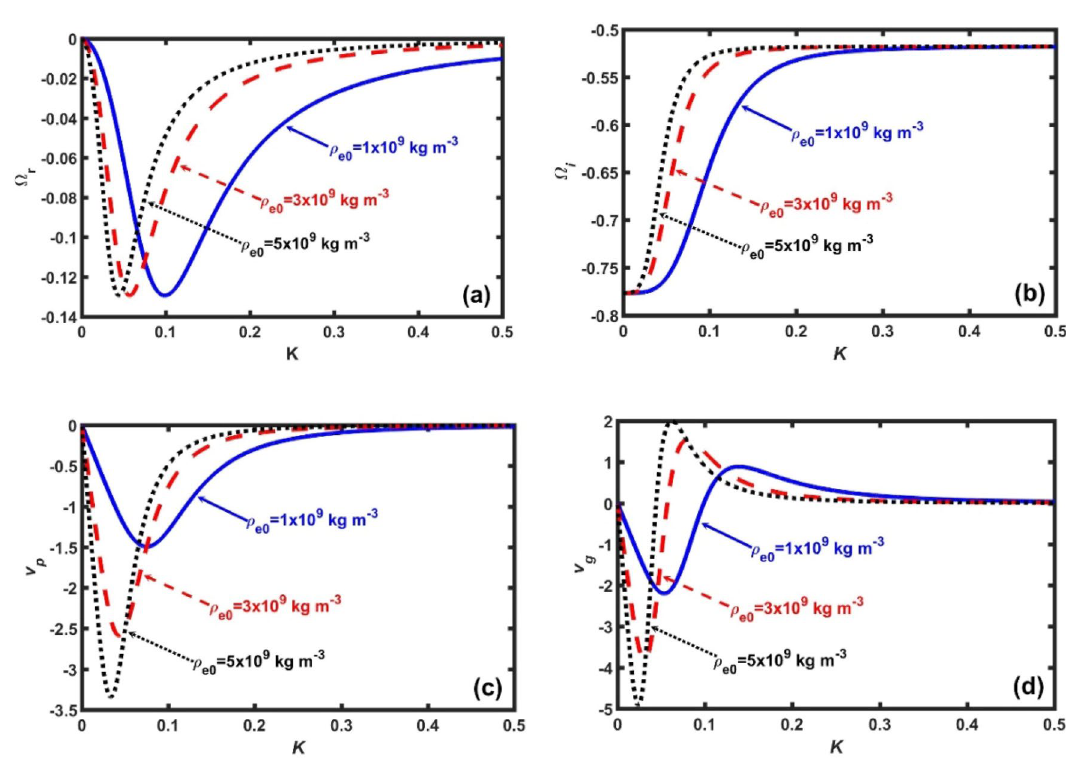
1 10 15 kg m −3 (fixed). The different lines link to ρ = ×